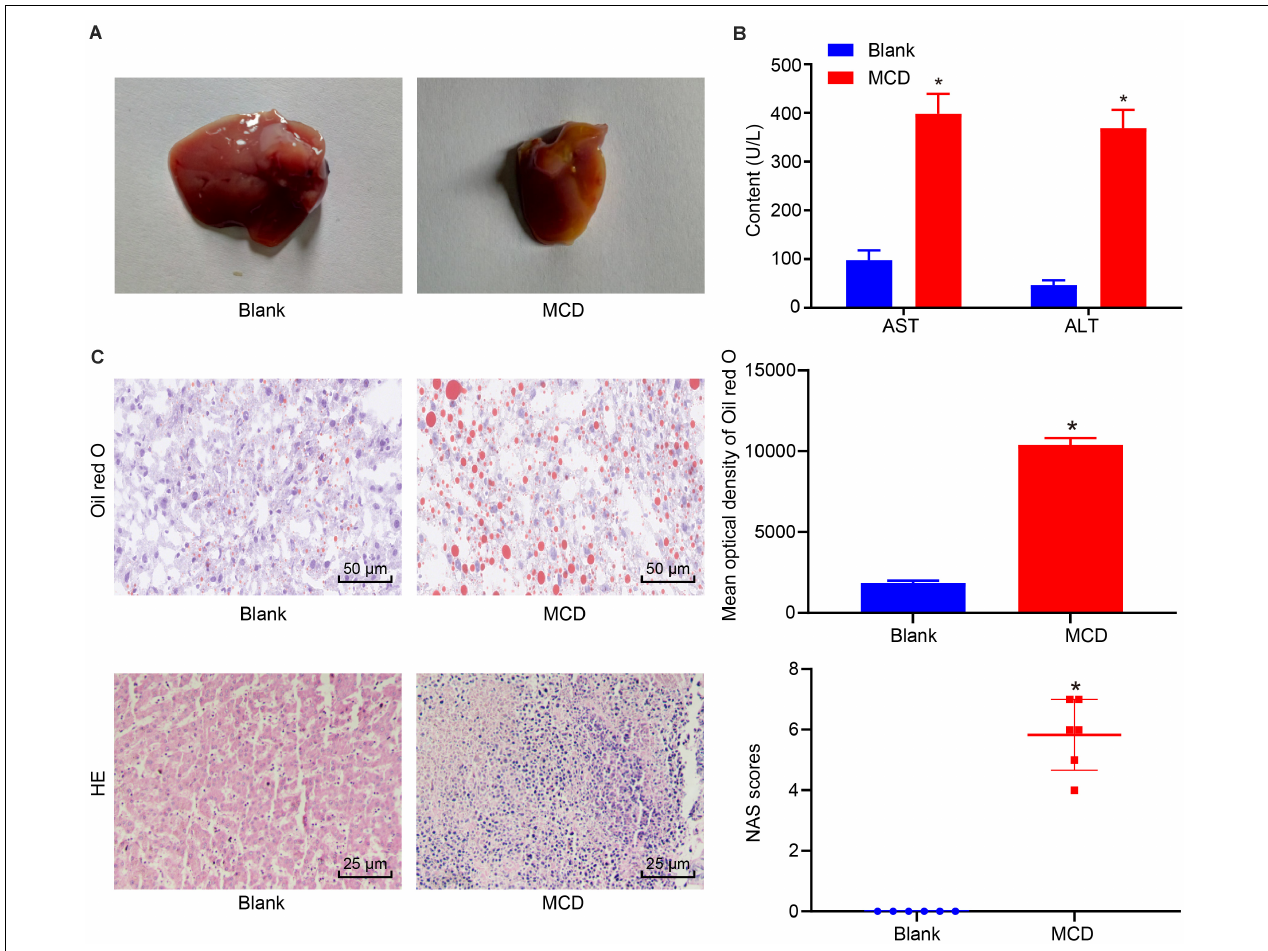
FIGURE 2 | Successful establishment of the mouse NASH model. (A) Representative images of liver resected from mice with normal diet and 5 weeks of MCD diet. (B) Serum levels of ALT and AST in mice on normal and 5-week MCD diets. (C) Pathological changes of liver tissue in mice on normal and 5-week MCD diets detected by Oil Red O staining ( × 200) (the upper diagram) and HE staining ( × 400) (the lower diagram). * p < 0.05 vs. the blank group (mice on normal diet). All data were measurement data and expressed as mean ± standard deviation. Comparison between two groups was analyzed using unpaired t -test. N = 6. NASH, non-alcoholic steatohepatitis; MCD, methionine–choline deficient; ALT, alanine aminotransferase; AST, aspartate aminotransferase; HE, hematoxylin–eosin.